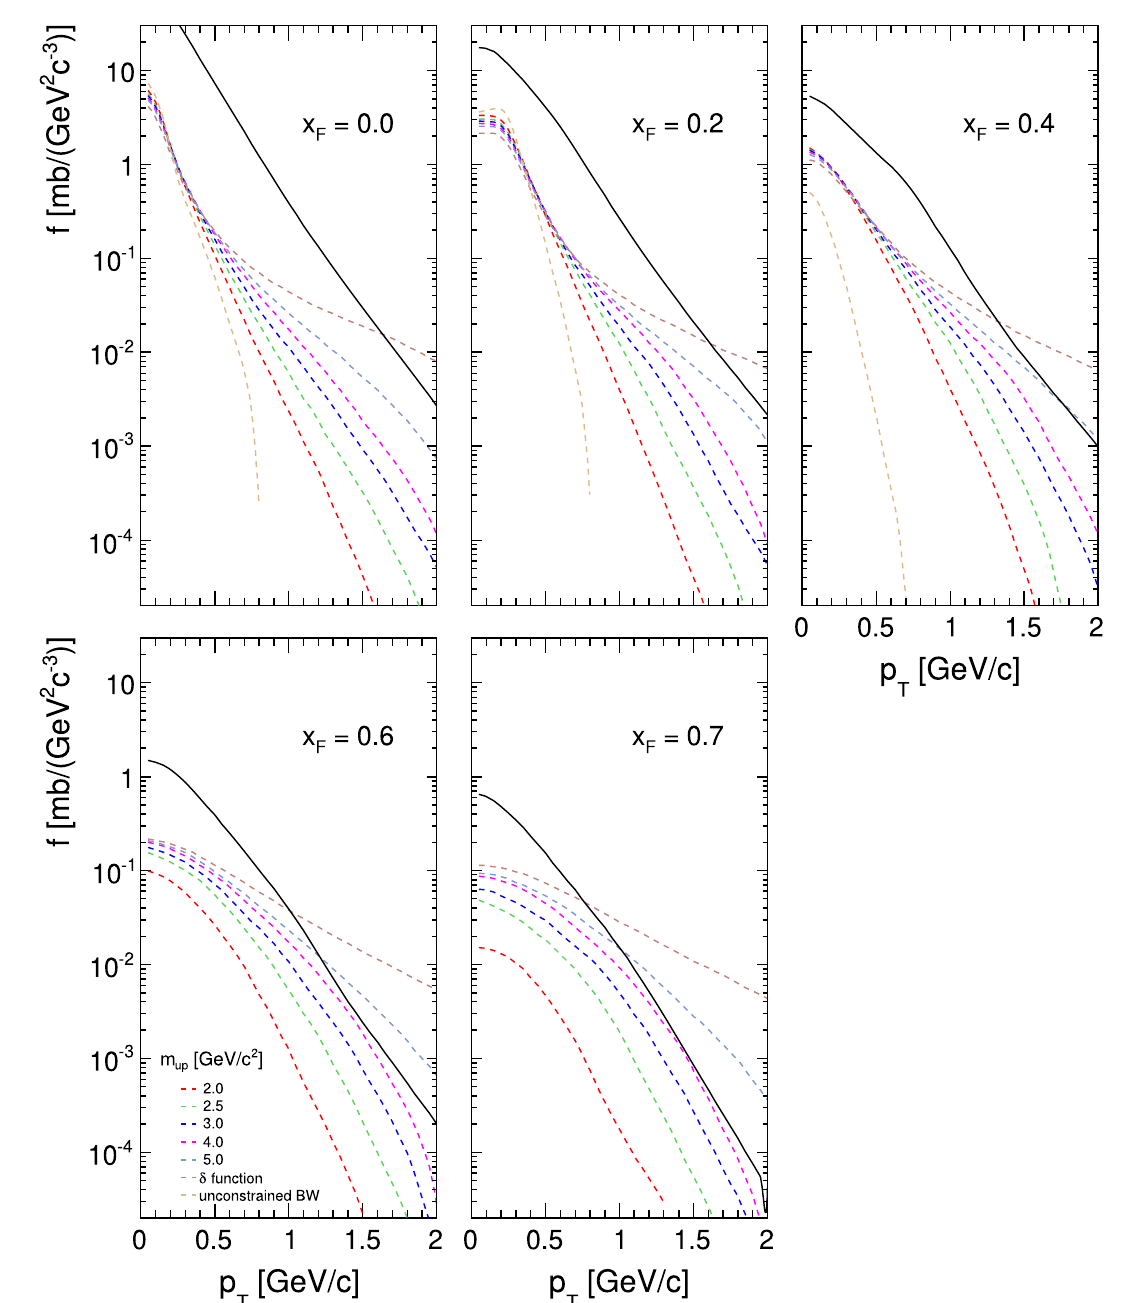
√ s = 17.2 GeV. The measured total